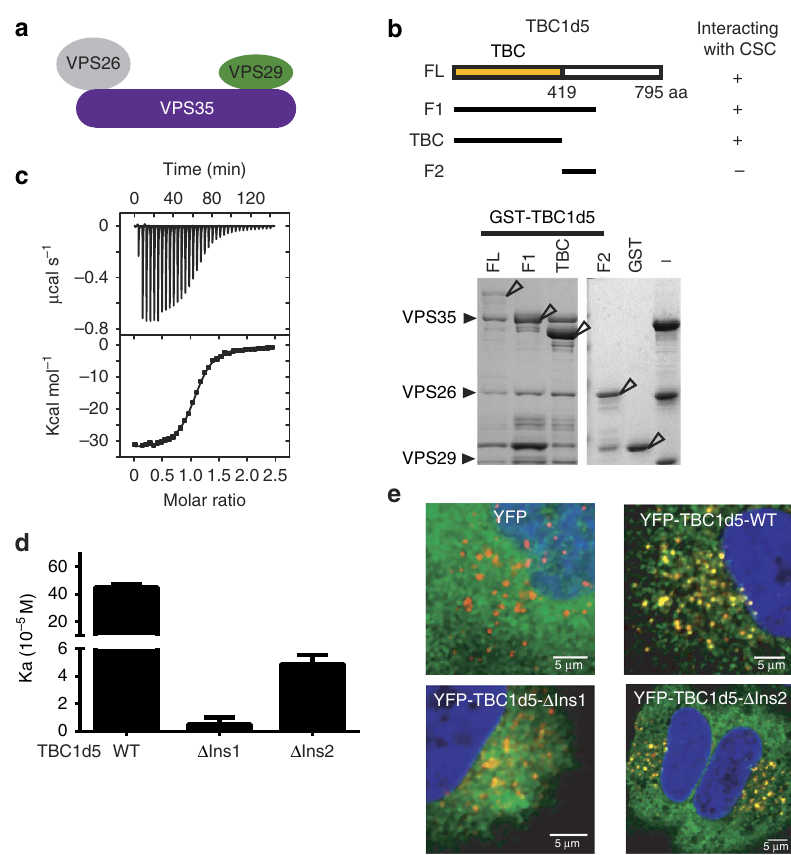
Figure 1 | TBC1d5 forms a tight complex with the retromer CSC. ( a ) Schematic representation of retromer CSC. ( b ) GST–TBC1d5 pull down of purified retromer CSC. Shown is the TBC1d5 constructs used (top) and a Coomassie blue stained SDS–PAGE gel of bound samples. Open triangles indicate GST–TBC1d5 or GSTproteins. ( c ) ITC of TBC1d5 TBC titrated into CSC in buffer containing 20mM Tris-HCl pH 8.0, 200mM NaCl and 5mM b ME at 20 (cid:2) C. Top and bottom panels show raw and integrated heat from injections, respectively. The black curve in the bottom panel represents a fit of the integrated data to a single-site binding model. ( d ) Affinity between CSC and TBC1d5 TBC WT, D Ins1 or D Ins2 determined by ITC. Association constant ( K a ) are shown together with errors from data fitting. ( e ) Subcellular localization of TBC1d5 WT, D Ins1 and D Ins2. Hela cells were transfected with yellow fluorescent protein (YFP) or various YFP–TBC1d5 (green) and then fixed and labelled with anti-VPS35 antibodies (red). The larger images from which these were captured are shown in Supplementary Fig. 3B. Scale bar, 5 m